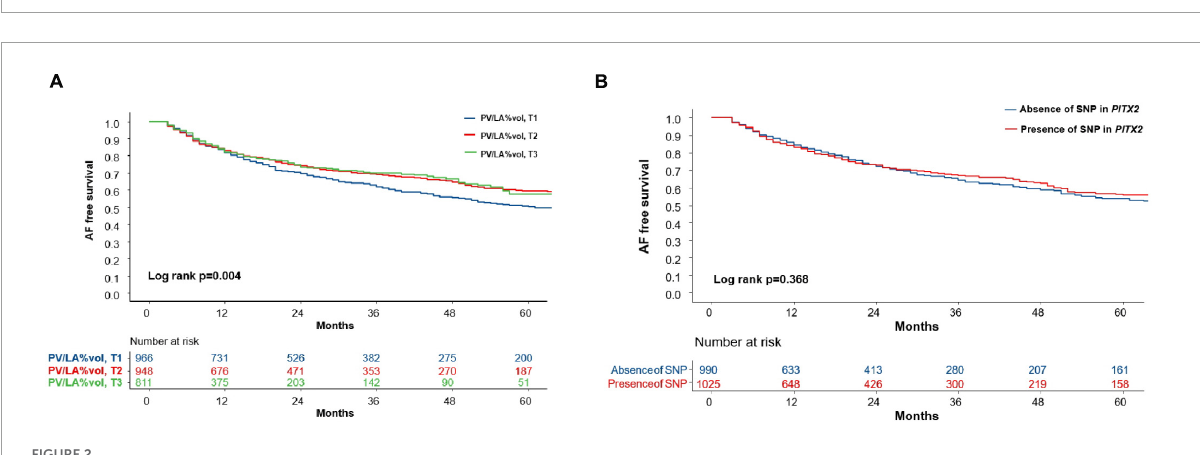
FIGURE2 The Kaplan-Meier curve for clinical recurrence of AF according to the tertile groups of PV/LA%vol and presence of the PITX2 gene. (A) The AF recurrence rate was significantly higher in the lowest tertile PV/LA%vol group (Log-rank p = 0.004). (B) However, AF recurrence did not differ according to the presence of an SNP in the PITX2 gene (Log-rank p = 0.368). AF, atrial fibrillation; PV/LA%vol, pulmonary vein to left atrium volume percent ratio; SNP, single nucleotide